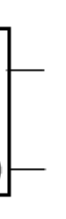
Figure 15. The icon of the encapsulated full